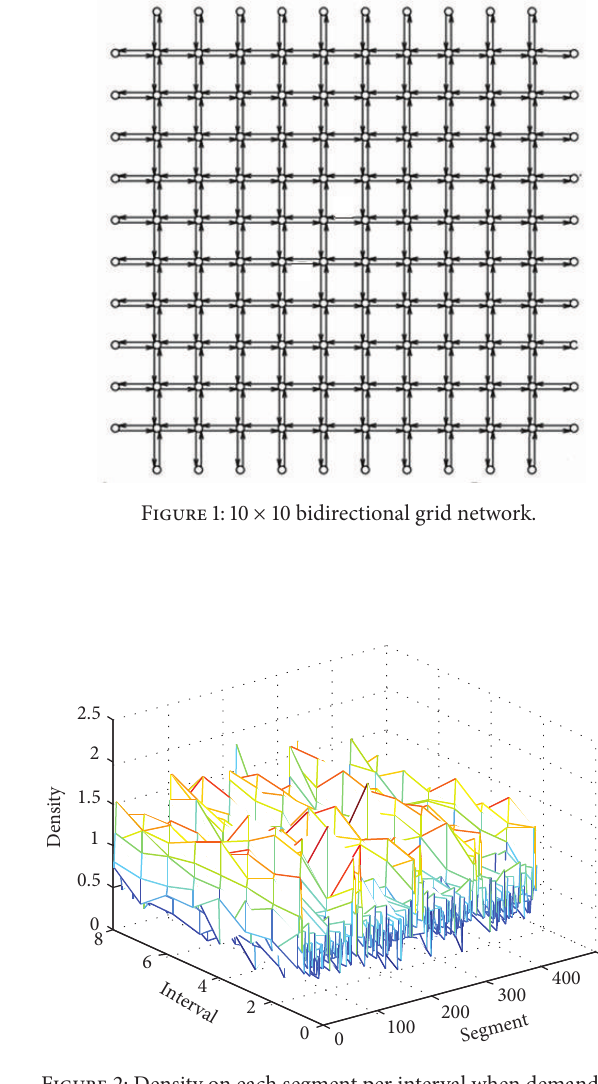
Figure 2: Density on each segment per interval when demand is 1.